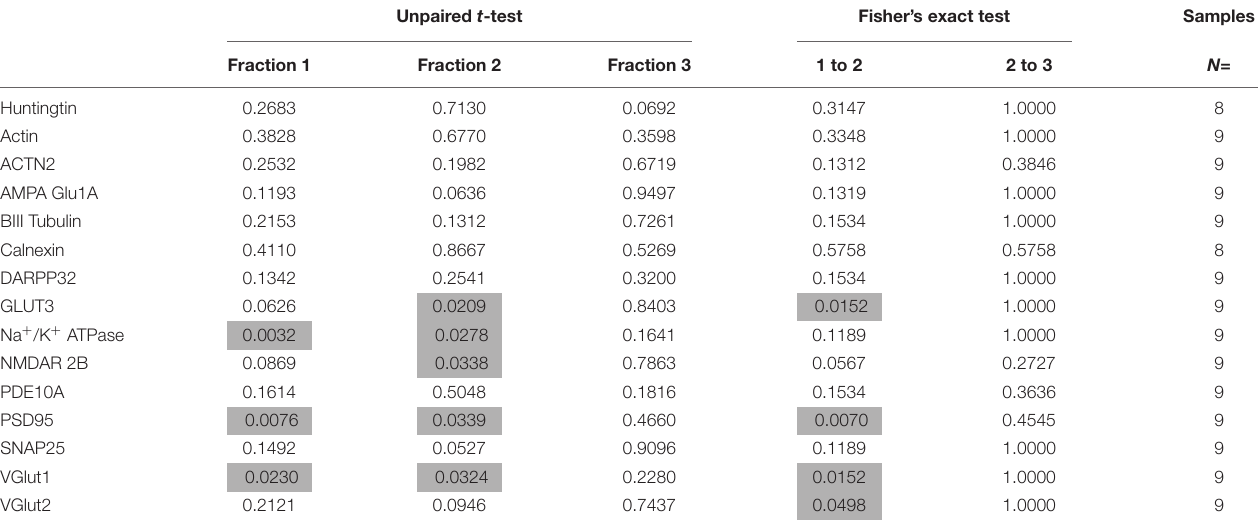
TABLE 1 | Statistical analysis for protein detection in fractions